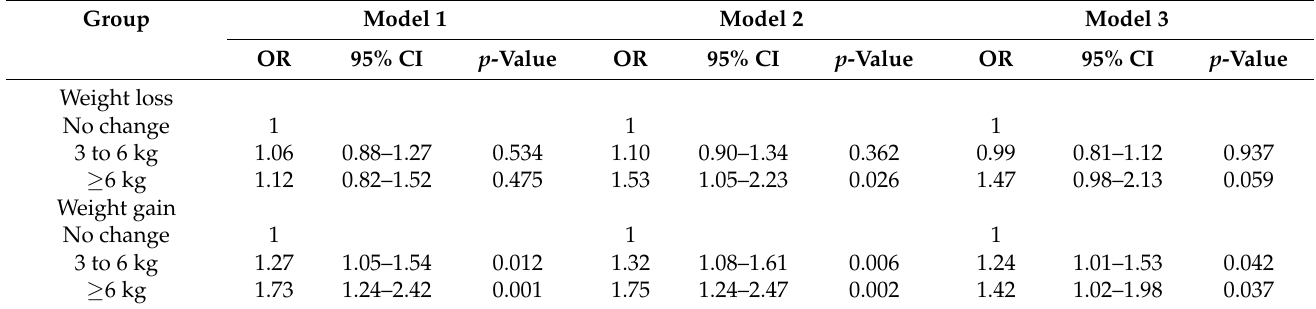
Table 3. Association between the amount of weight change and low back pain using multiple logistic regression.